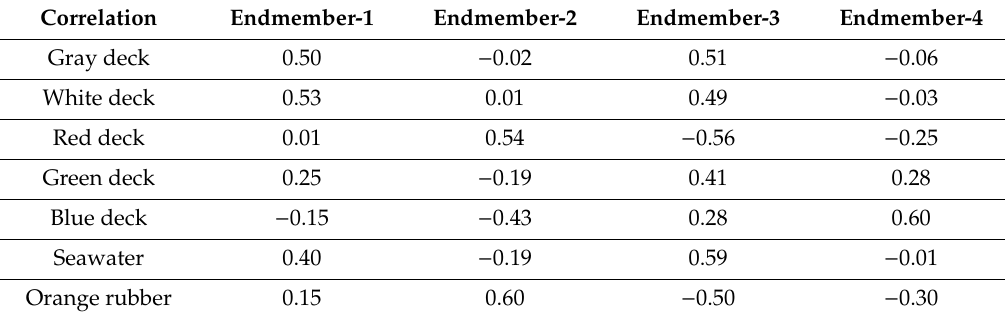
Table 2. Correlation coe ffi cient between endmember and marine library